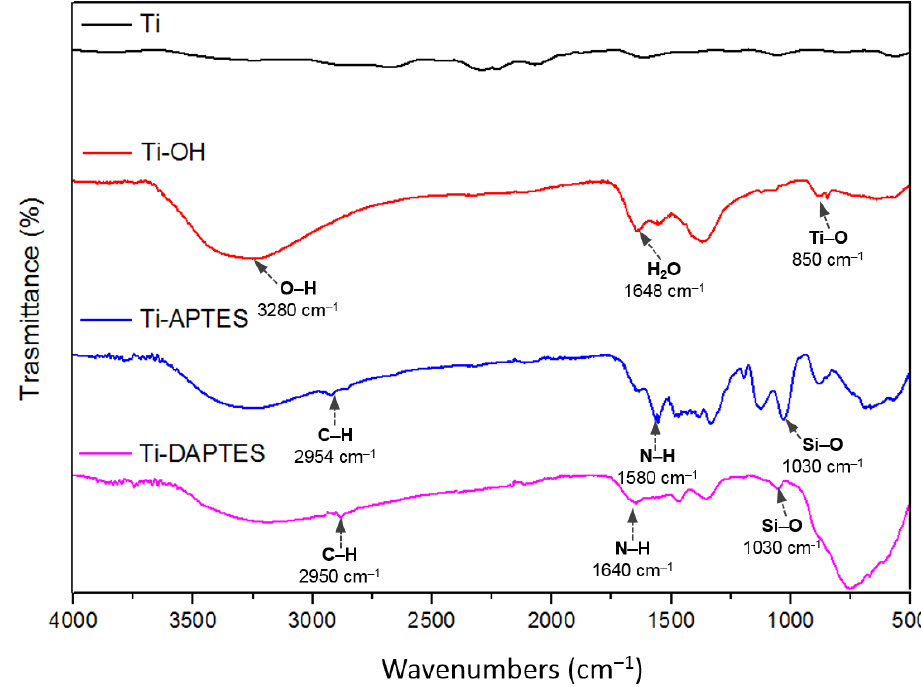
Figure 2. FTIR spectra of bare titanium sample (Ti), of the oxidized sample Ti-OH and of the silanized samples Ti-APTES and Ti-DAPTES. ‒ 242